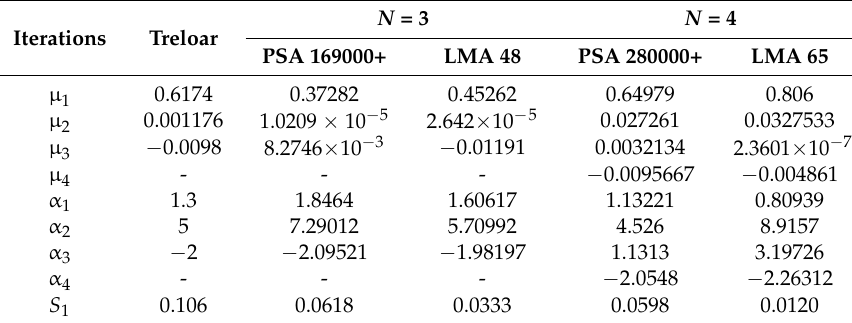
Table 1. Results of the identified parameters in Ogden model.